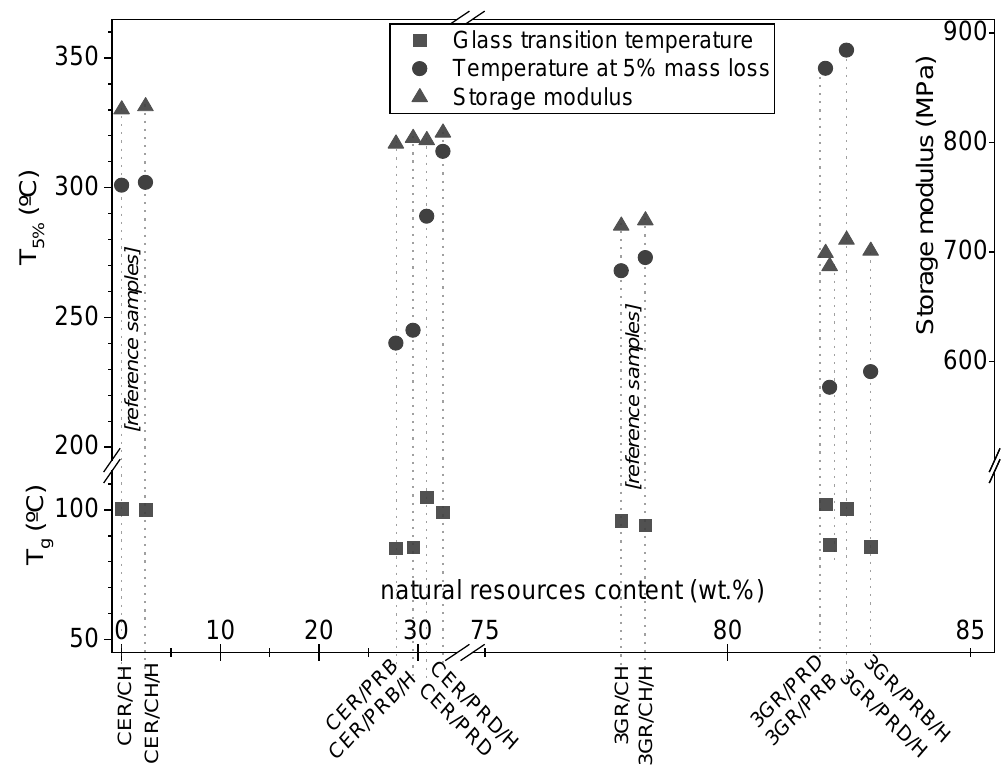
Figure 4. Content of natural resources in prepared coatings and reference samples and their values of glass transition temperature (T g ) and temperature at 5% mass loss (T 5% ). Symbols are explained in Table 2.